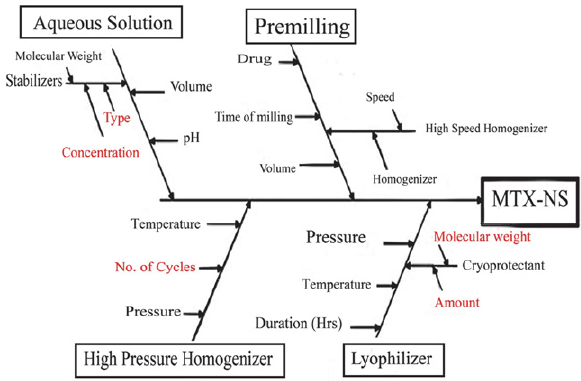
Figure 2. Ishikawa Diagram illustrating process and formulation variables that may have an influence on the properties of MTX-NS